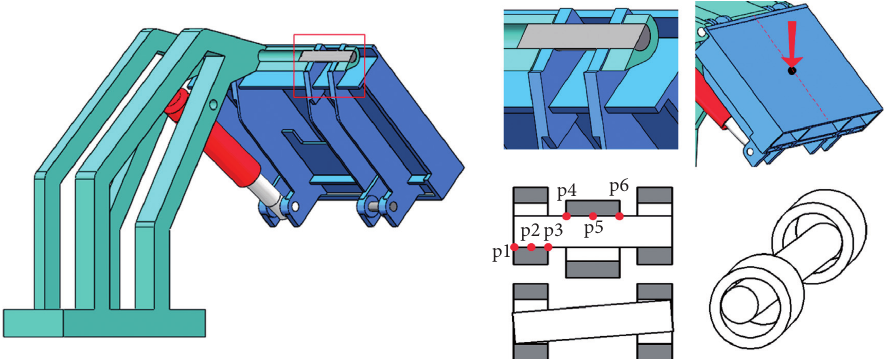
Figure 4: The nonuniform force and disorderly motion of the pin